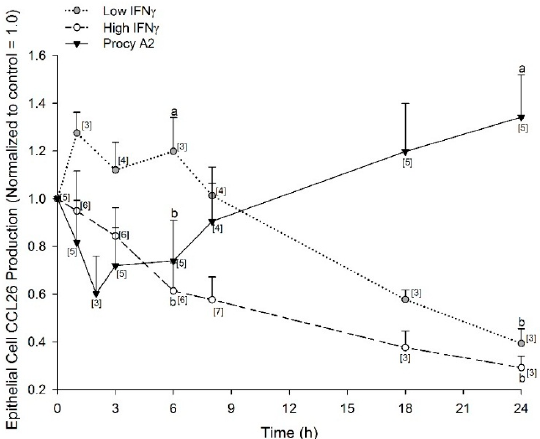
Figure 5. IFN γ and procyanidin A2 inhibit IL-4- stimulated CCL26 production in a time-dependent manner. A549 cells were seeded at 5 × 10 5 in 12-well plates, serum starved for 24 h and incubated for 1–24 h with low IFN γ (0.5 nM, grey dots), high IFN γ (5.8 nM, open dots) or procyanidin A2 (Procy A2; 5 μ M, black triangles), washed with PBS and then stimulated with 5 ng/mL IL-4 for 24 h. Collected supernatants were measured for CCL26 by ELISA. Results expressed as mean ± SEM normalized to control = 1.0, which were from 3–7 separate experiments and 9–21 individual measurements. Brackets, [ n ], indicate number of experiments for each data point. Different letters “a” and “b” at 6 h or 24 h represent statistical difference, p < 0.05.